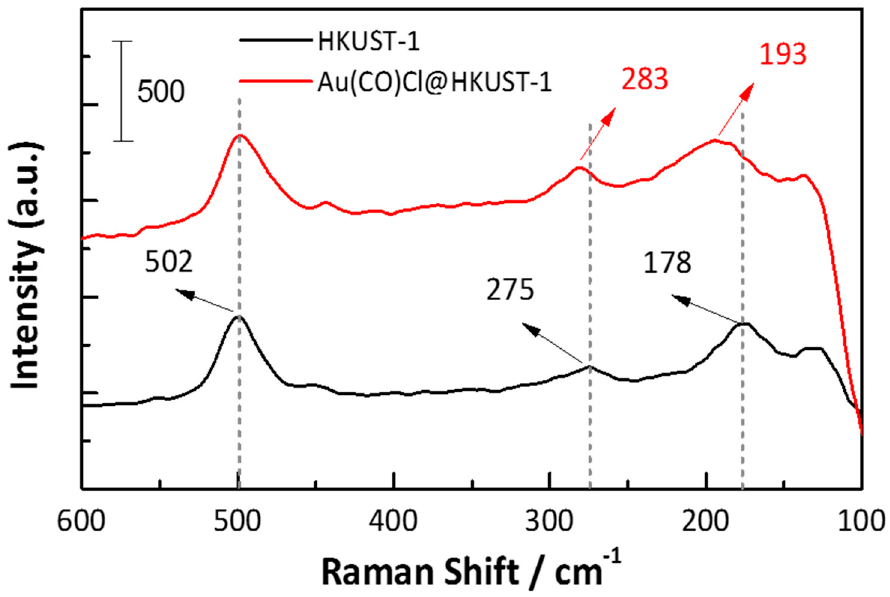
Figure 6. Raman spectra of empty HKUST-1 (black) and Au(CO)Cl@HKUST-1 SURMOFs (red). The dip of the Raman spectrum of Au(CO)Cl@HKUST-1 at the low-frequency end is due to a broad-band luminescence, which is known for small Au x nanoclusters [53,54], still remaining after the subtraction of the baseline from the background spectra.